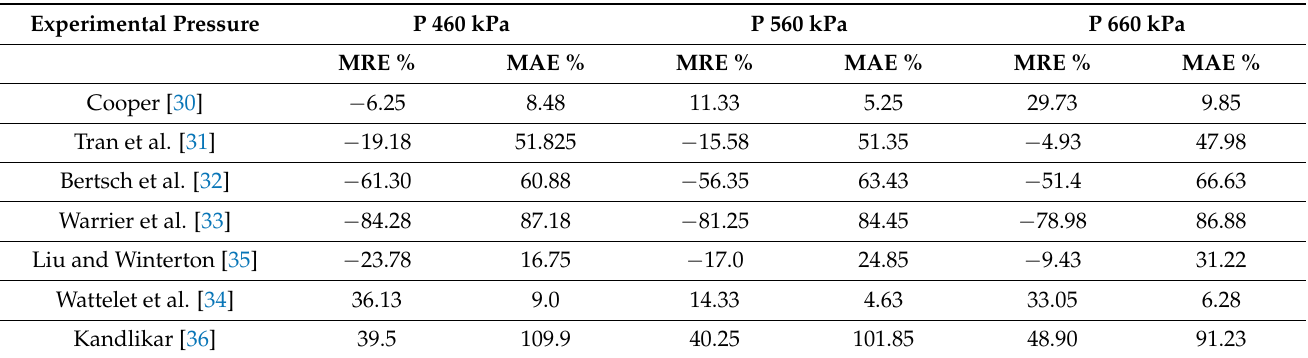
Table 9. Statistical analysis of the comparison between experimental heat transfer coefficient and prediction models for all data at saturation pressures of 460–660